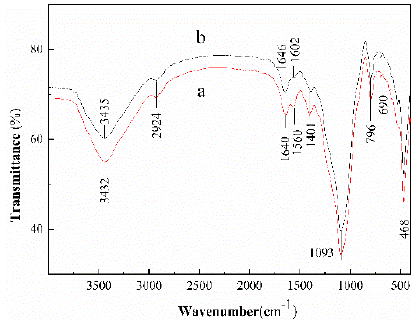
Figure 2. The FTIR spectra of ( a ) CS-modified and ( b ) CS-modified Dt after adsorption.